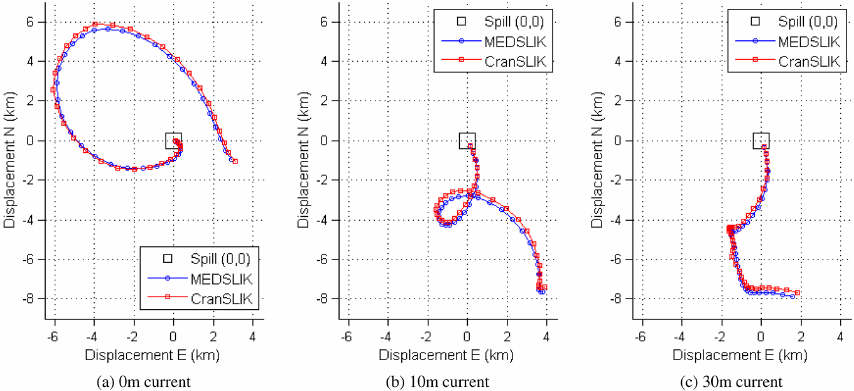
Figure 2. Centre of mass trajectory forecasts (hours 1–36) for the Algeria point case using the current at different depths as the advective current.